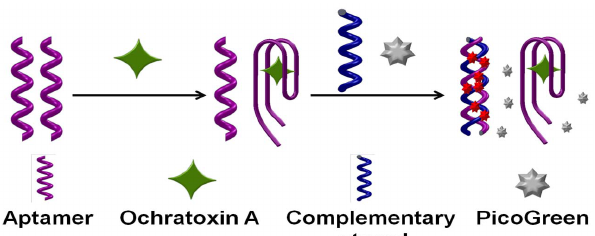
Figure 1. Schematic illustration of fluorescent detection of OTA by a label-free aptasensor.